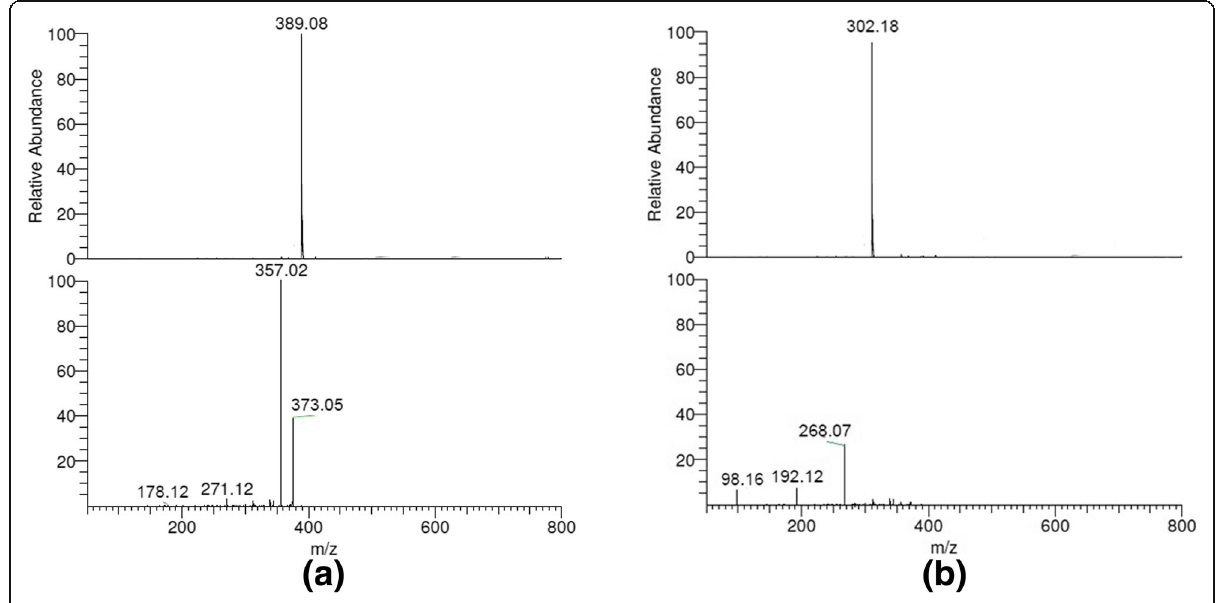
Fig. 6 LC-MS and LC-MS/MS spectra of a DP IV and b DP V